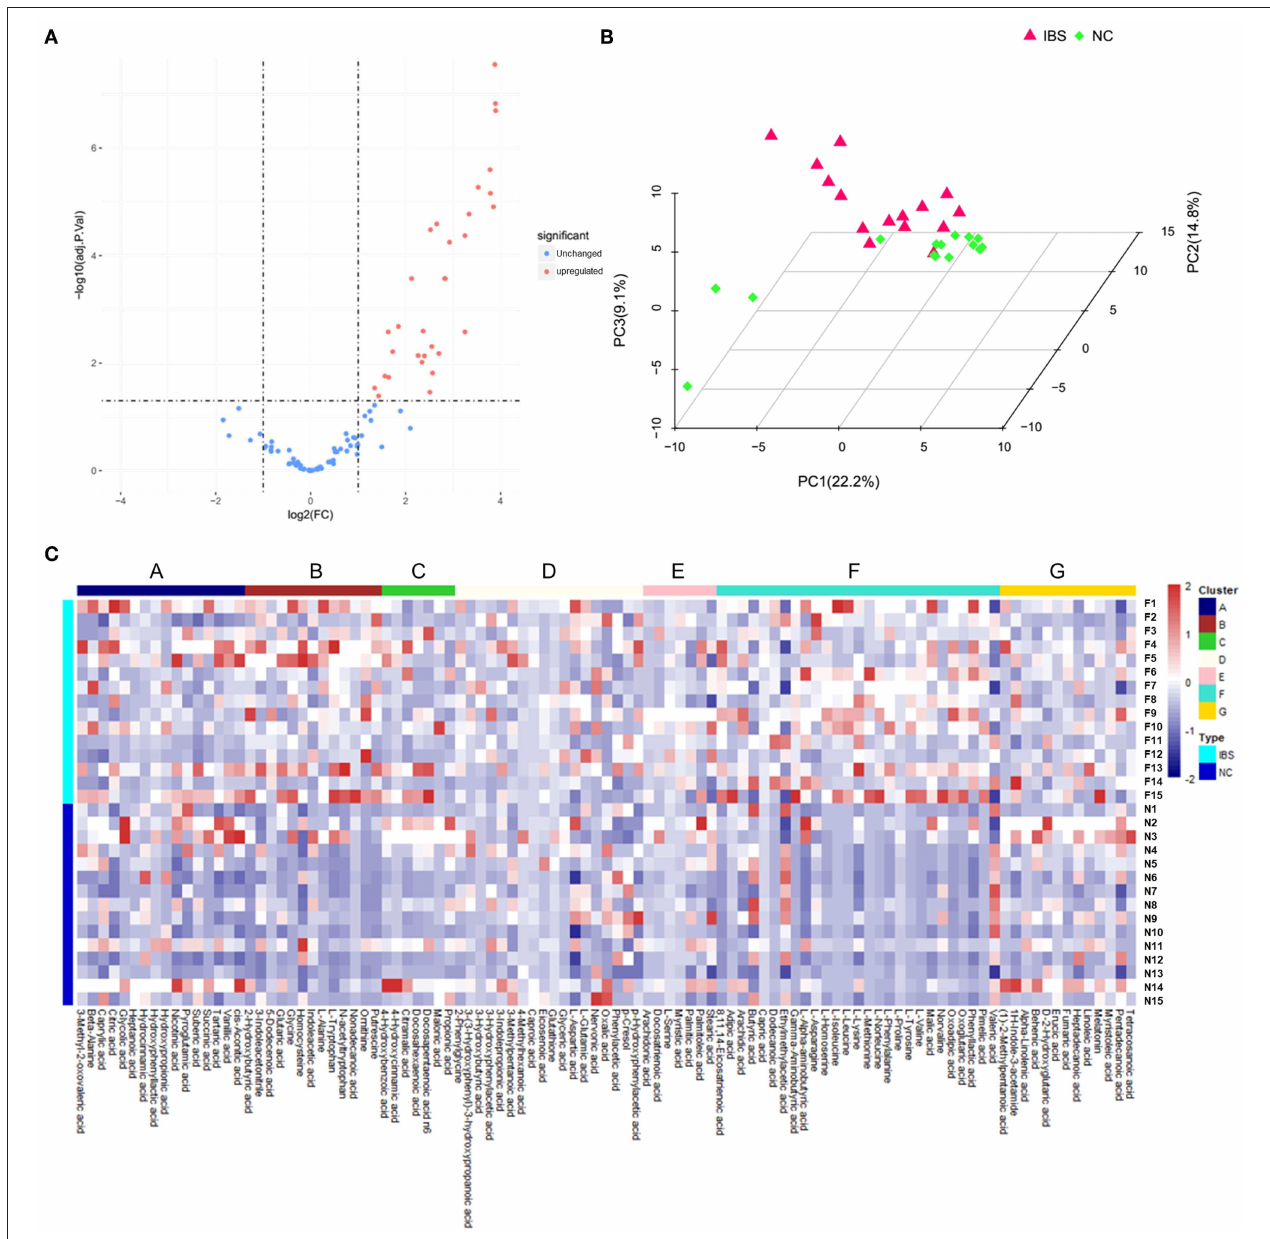
FIGURE 1 | Metabolic profiling analysis in IBS and Healthy controls. (A) Volcano Plots revealed that there were 31 significantly up-regulated metabolites (red dots) in IBS patients compared to the healthy controls. (B) Principal component analysis (PCA) showed markedly different component profiles between the two groups. (C) The heatmap profile showed that all metabolites detected were divided into seven clusters. The clusters A–C, and F were significantly upregulated in the IBS group as compared to the healthy controls.